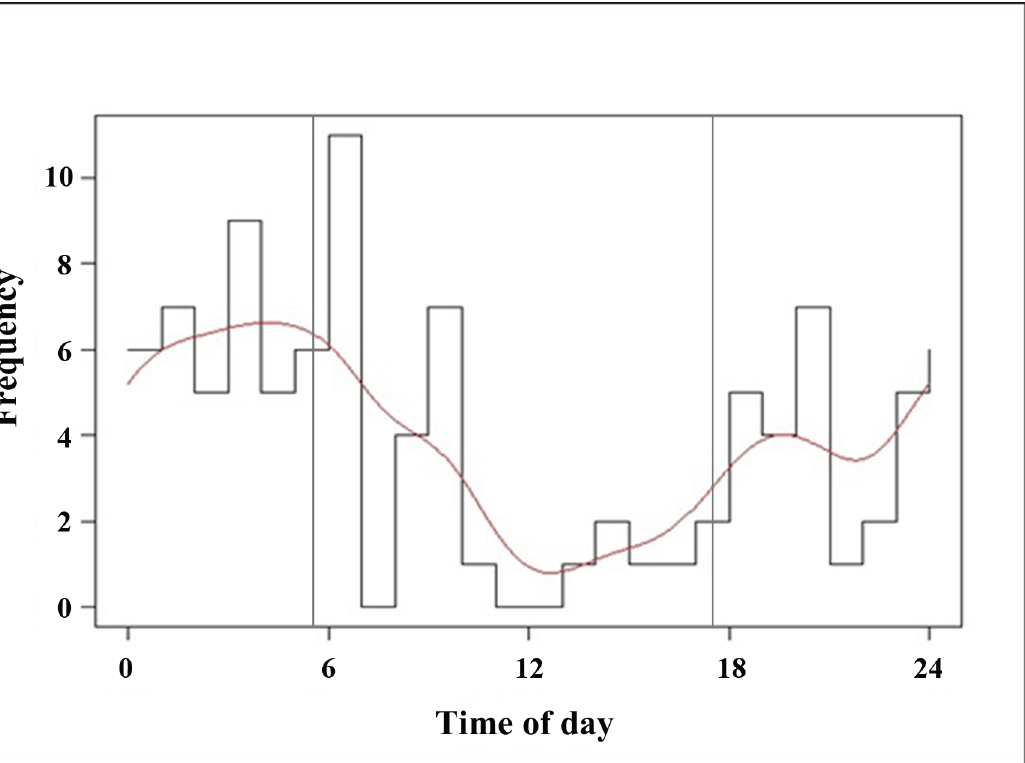
Fig 3. Proportion of observations per time of day spent active fitted with a line function using the activity package in R [33] to determine proportion of time spent active. Vertical lines indicate sunrise and sunset at approximately 05.30 and 17.50 year-round.